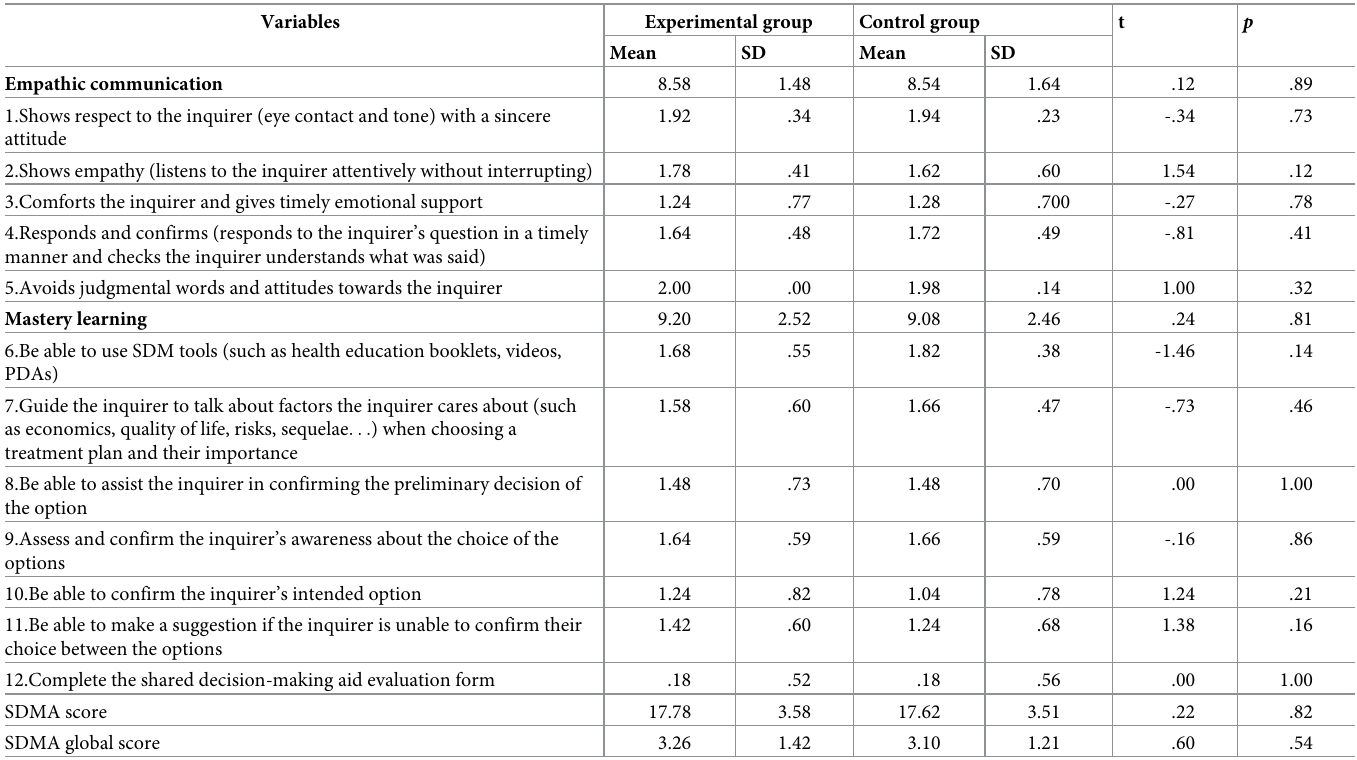
Table 2. Intergroup differential analysis of the OSCE scores of the two groups.